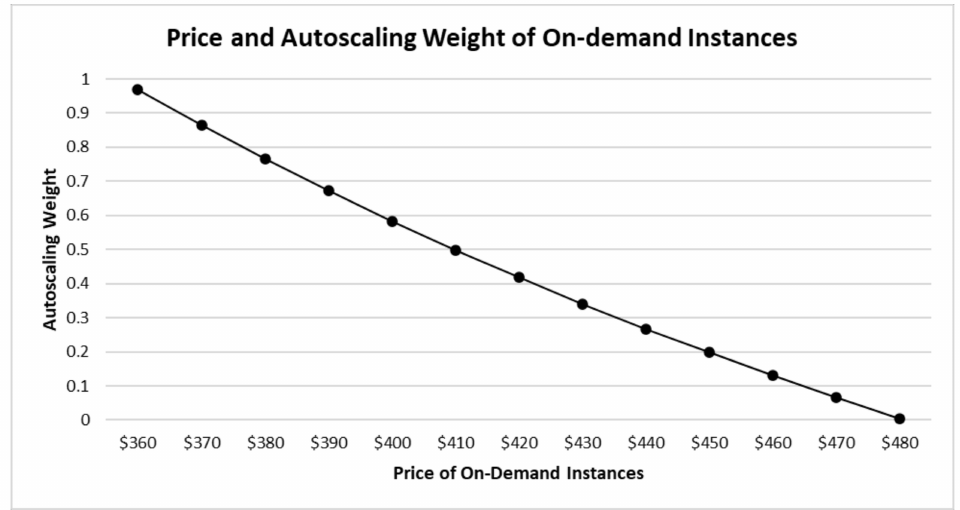
Figure 3. Price of On-demand Instance and Autoscaling Weight of On-demand Instances.